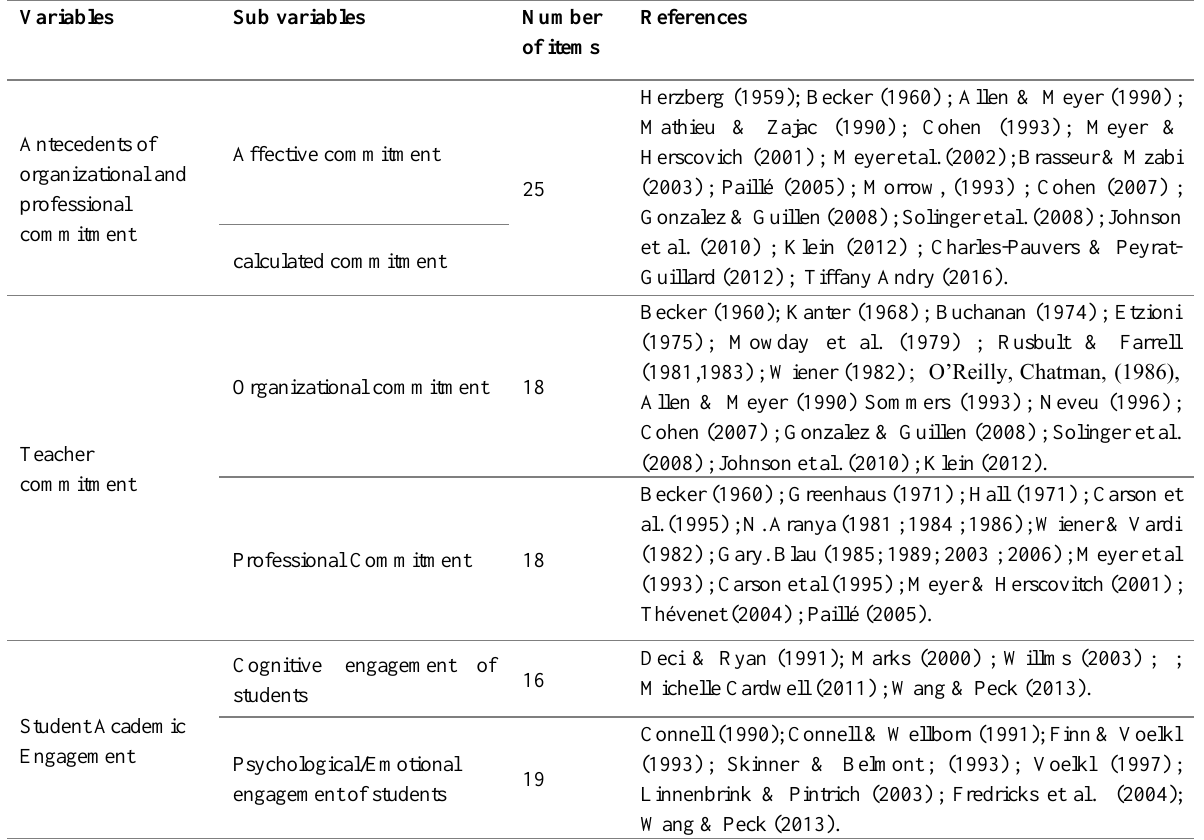
Table 3: List of variables and number of research